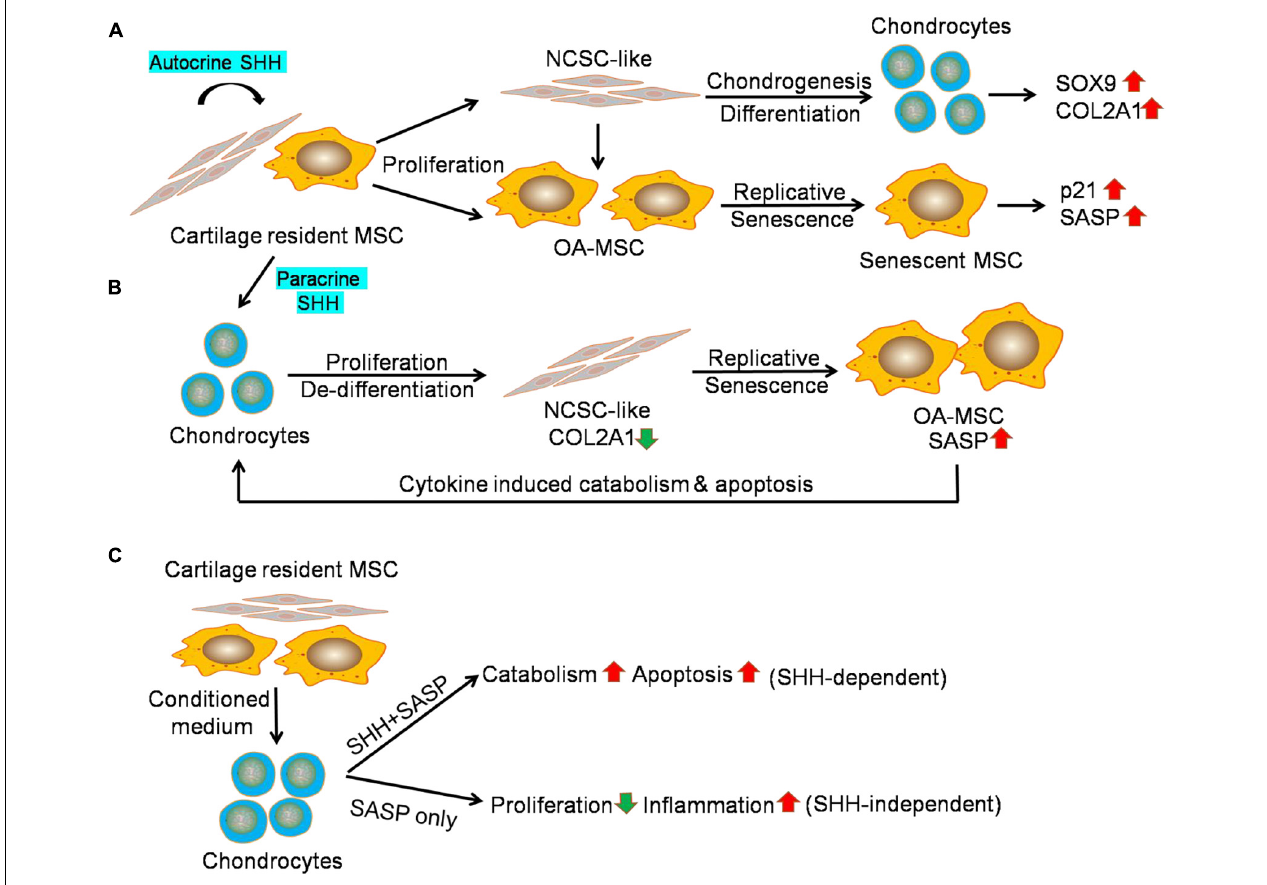
FIGURE 7 | Sonic hedgehog (SHH) mediates interaction of mesenchymal stromal cell (MSC) and chondrocytes in human osteoarthritis (OA) articular cartilage. (A) Working hypothesis of the effect of autocrine SHH on cartilage MSC. Cartilage MSC contains heterogeneous populations of NCSC-like MSC and senescent OA-MSC. SHH stimulates proliferation of NCSC-like MSC and induces chondrogenic differentiation. It results in the elevation of chondrogenesis markers including SOX9 and COL2A1 . SHH also stimulates proliferation of OA-MSC and induces replicative senescence. It results in the elevation of cell senescence markers including p21 and SASP IL1B . (B) Working hypothesis of the effect of paracrine SHH on chondrocytes. SHH stimulates proliferation and de-differentiation of OA chondrocytes. It results in a decrease of expression of chondrocyte marker COL2A1 . SHH also induces replicative senescence of cartilage MSC. It results in the elevation of cell senescence markers including pro-inflammatory cytokines. Upon binding to the receptors, cytokines induced catabolism and apoptosis in OA chondrocytes. (C) Working hypothesis of the effect of OA-MSC on OAC revealed by the conditioned medium experiment data. The OA-MSC conditioned medium inhibited chondrocyte proliferation and induced catabolism, apoptosis, and inflammation in chondrocytes. While chondrocyte catabolism and apoptosis depend on OA-MSC-derived SHH, inhibition of chondrocyte proliferation and stimulation of chondrocyte inflammation are SHH independent. SHH may regulate these events indirectly through inducing OA-MSC cell senescence and senescence-associated secretory phenotype (SASP)